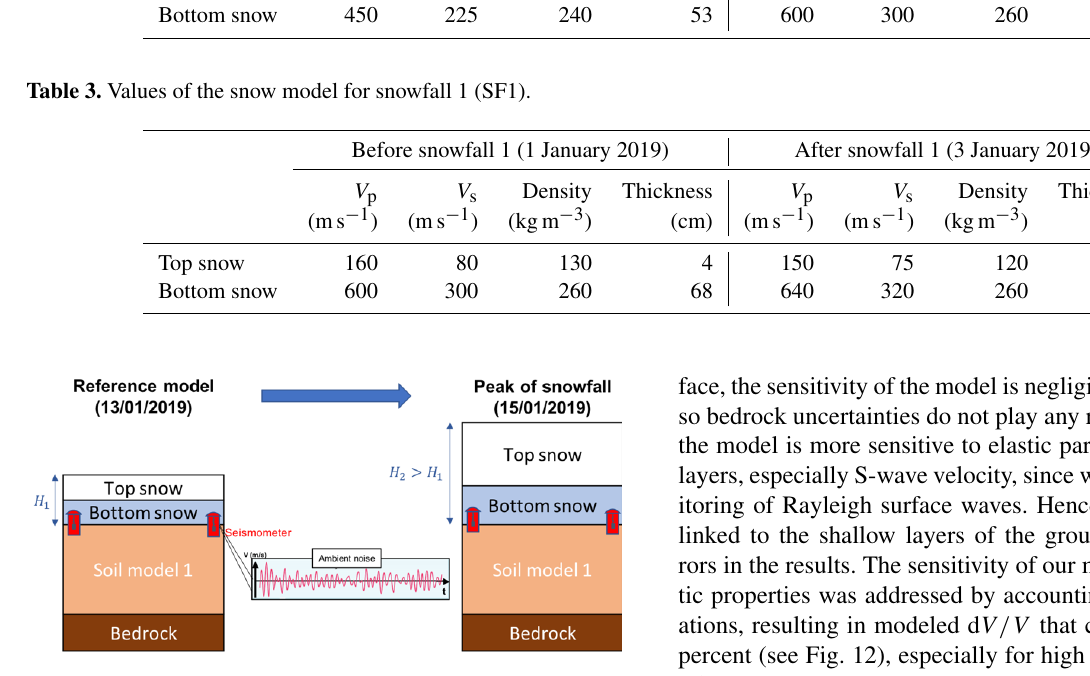
Figure 11. Schematic 1D cross-section of the instrumentation of the study site, with the location of seismic sensors buried in the shallow subsurface, and the modeled layered medium at two temporal steps (before and during peak of snowfall event 2, as an example). The only changes between these models are the increasing snow depth and mechanical properties of both snow layers, as specified in Ta- ble